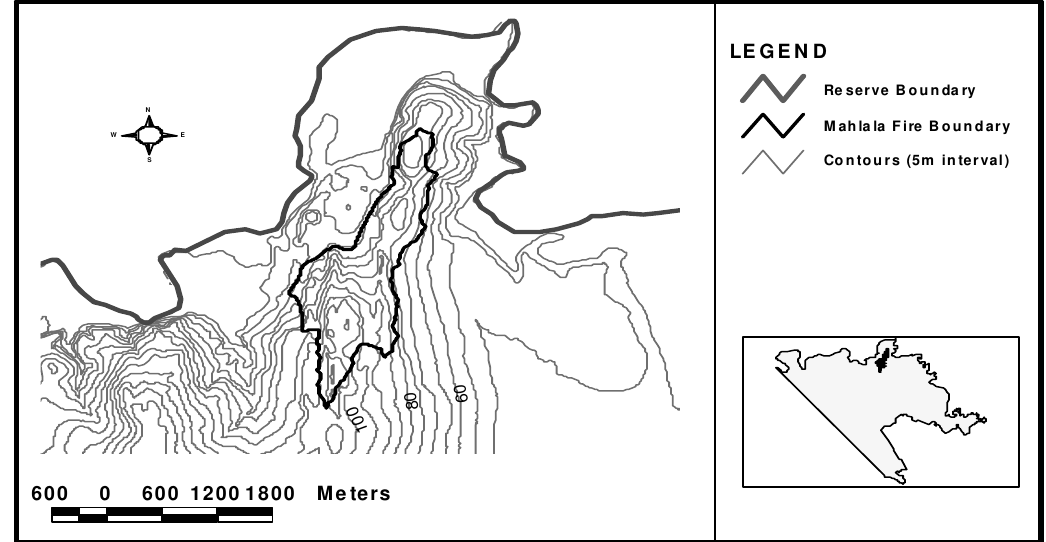
Figure 3. Map of contours at 5m intervals for the Mahlala